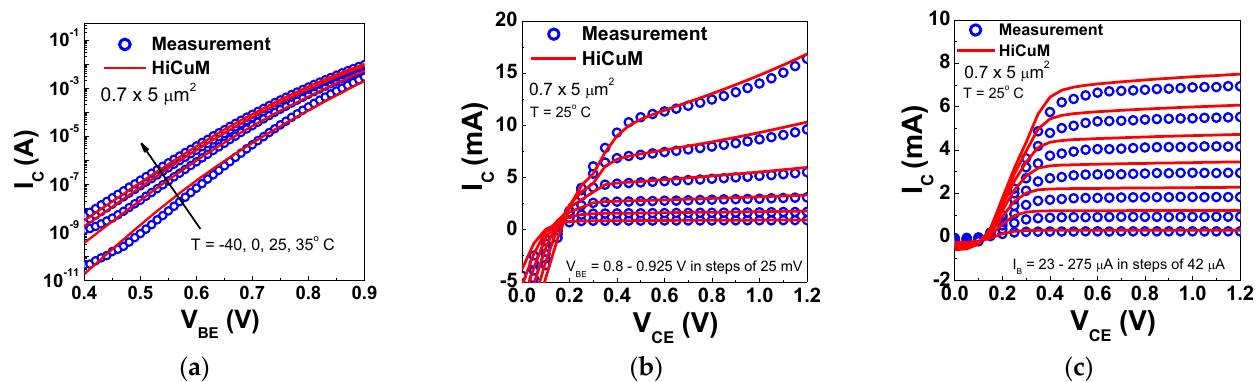
Figure 5. ( a ) Collector current at different temperatures; output characteristics at forced V BE ( a ) and at forced I B ( b ), for the InP DHBT with an area of 0.7 × 5 µm 2 .